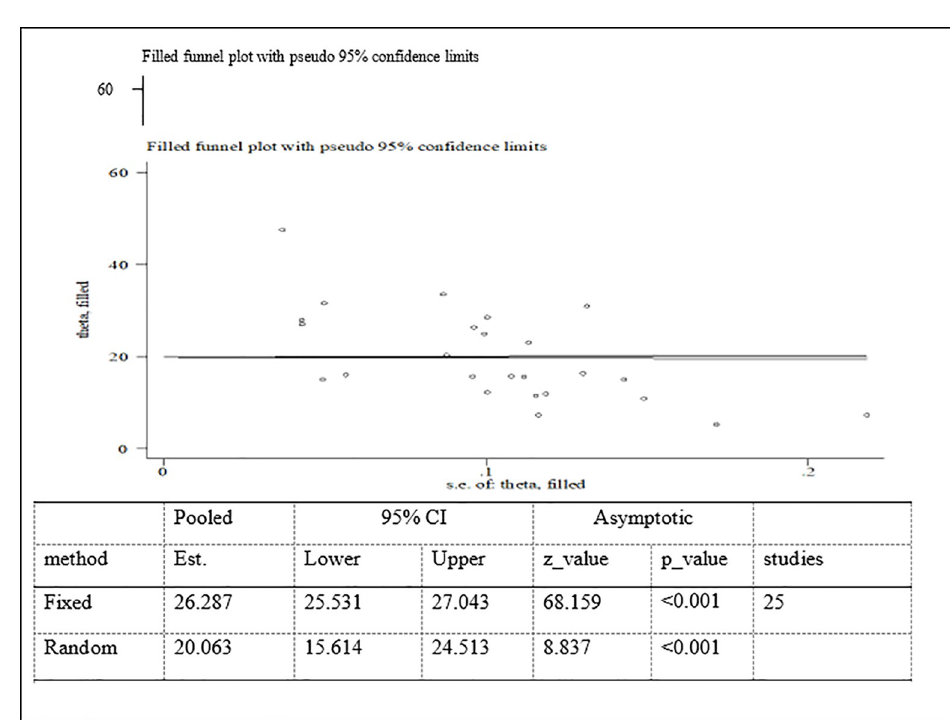
Fig 11. Trim and fill analysis for stunting among adolescent in Ethiopia.